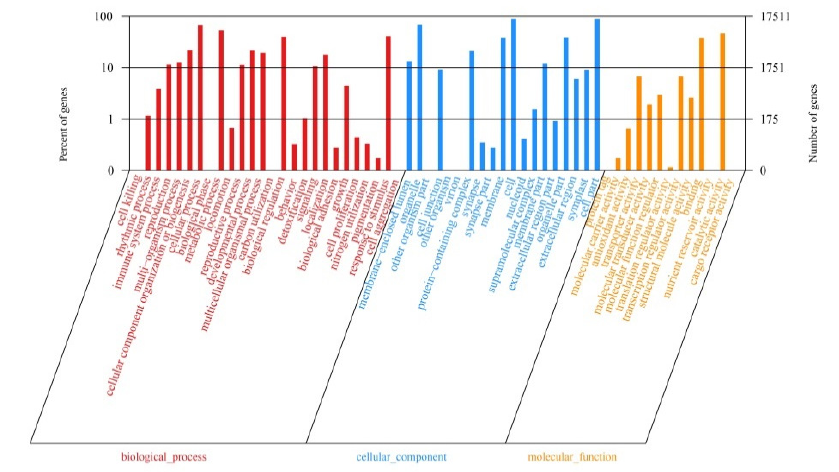
Figure 3. Gene ontology (GO) term classifications of special orthogroups in Chosenia arbutifolia .